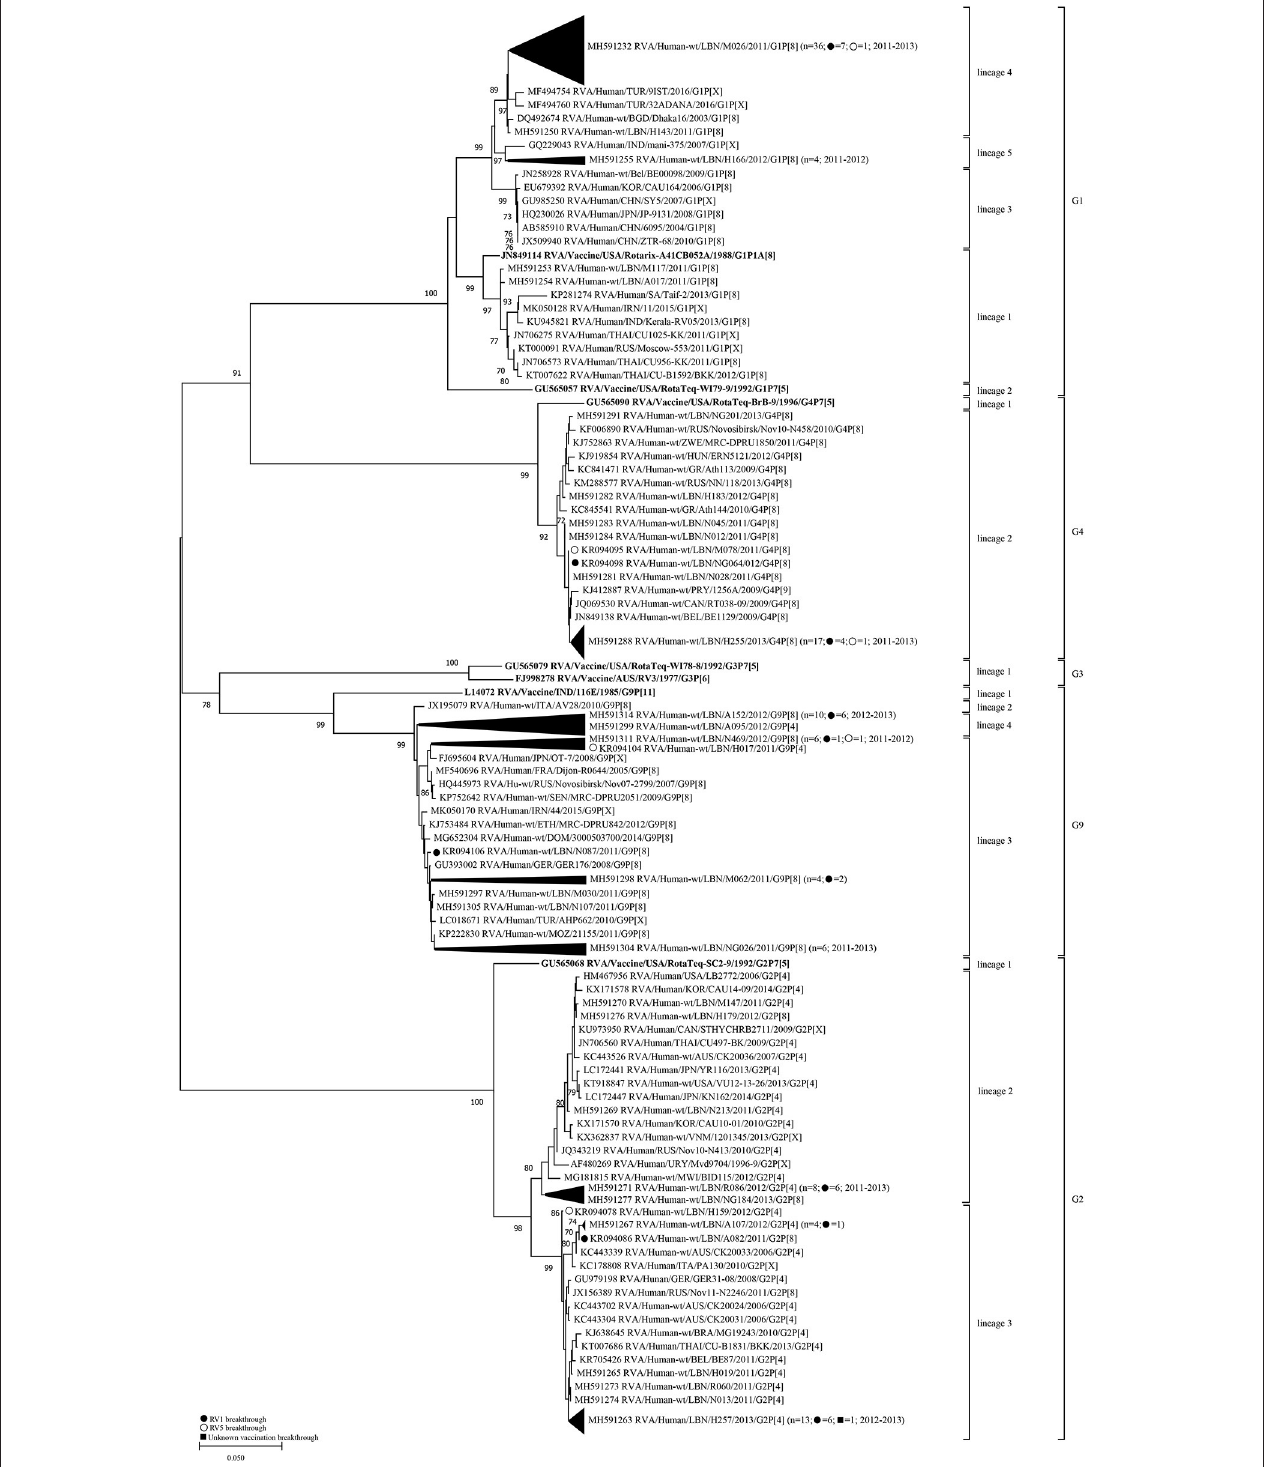
FIGURE 1 | Phylogenetic dendrogram of VP7 genes (reading frame sequences 1-951) of RVA strains circulating in Lebanon (2011-2013) in relation to globally representative strains and those of Rotarix ® and RotaTeq ® . Phylogenetic analysis was performed using the neighbor-joining method. Horizontal branch lengths are drawn to scale (nucleotide substitutions per base) and bootstrap values (1000 pseudo-replicates) are shown at branch nodes. The annotation indicates strain ID/genotype/year of isolation. Branches comprised solely of Lebanese strains were collapsed and one representative strain was indicated for each branch. The total number of specimens in each collapsed branch and the years of isolation are indicated in parenthesis. The number of breakthrough specimens for each collapsed branch is also shown.